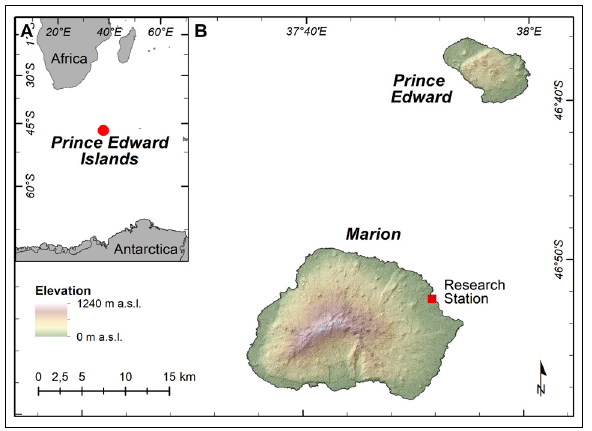
(A) The location of the Prince Edward Islands. (B) The location and size of Marion and Prince Edward Islands and their positions relative to one another. The South African National Antarctic Programme research station is situated on Marion Island. Maps similar to this figure are available for re-use through the online datasets.